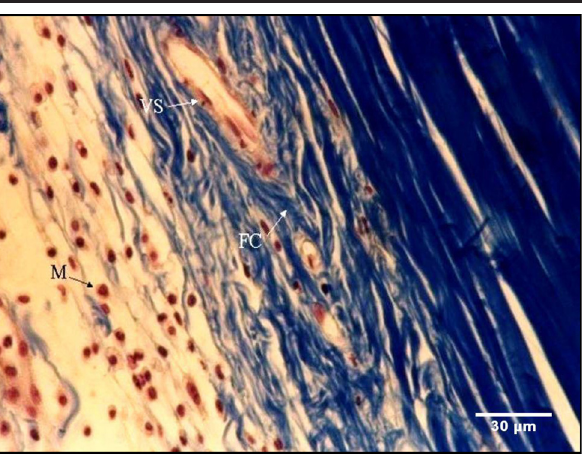
FIGURE 2 - Photomicrograph stained with Masson’s trichrome, showing concentration of collagen fibers (FC), macrophages (M) and blood vessels (VS) in group G2 animals (malnourished and treated for 3 days). 400X magnification.